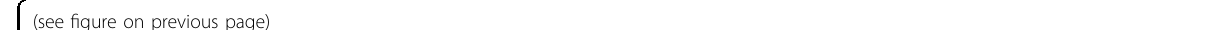
Fig. 4 Characterizations of CD8 + T cell subsets across the three conditions. a Condition preference of each cluster. Y -axis: average percent of samples across the three conditions. Conditions are shown in different colors. Each bar plot represents one cell cluster. Error bars represent ±S.E.M. for four healthy donors and 14 chronic HIV-1-infected individuals. * P < 0.05; ** P < 0.01; *** P < 0.001; two-sided unpaired Mann – Whitney U -test. b Box plots of the cytotoxicity and exhaustion scores across different clusters and conditions. Conditions are shown in different colors. Horizontal lines represent median values, with whiskers extending to the farthest data point within a maximum of 1.5× interquartile range. * P < 0.01; ** P < 0.001; *** P < 0.0001; two-sided unpaired Dunn ’ s (Bonferroni) test. c DEGs of CD8 + T cells from the TPs or ARTs in comparison with those from the HDs. Each red dot denotes an individual gene with Benjamini – Hochberg adjusted P value (two-sided unpaired Mann – Whitney U -test) ≤ 0.01 and average log 2 (fold change) ≥ 0.5 for the TP/HD and ART/HD comparisons. Example genes are labeled with the gene name. d Gene enrichment analyses of the DEGs in TPs compared with healthy donors. GO terms are labeled with name and id and sorted by − log10 ( P ) value. A darker color indicates a smaller P value. The top 20 enriched GO terms are shown. Interesting terms are labeled in red color. e Similar to b but for in fl ammation and IFN- α response score. f Dot plot showing expression of some genes associated with in fl ammation and IFN- α response processes across the three conditions. The size of the circle indicates the percentage of cells expressing pathway-associated genes under each condition. The color of the circle represents the expression levels of pathway-associated genes under each condition, and the color red means a relatively high expression level, and black means a relatively low expression